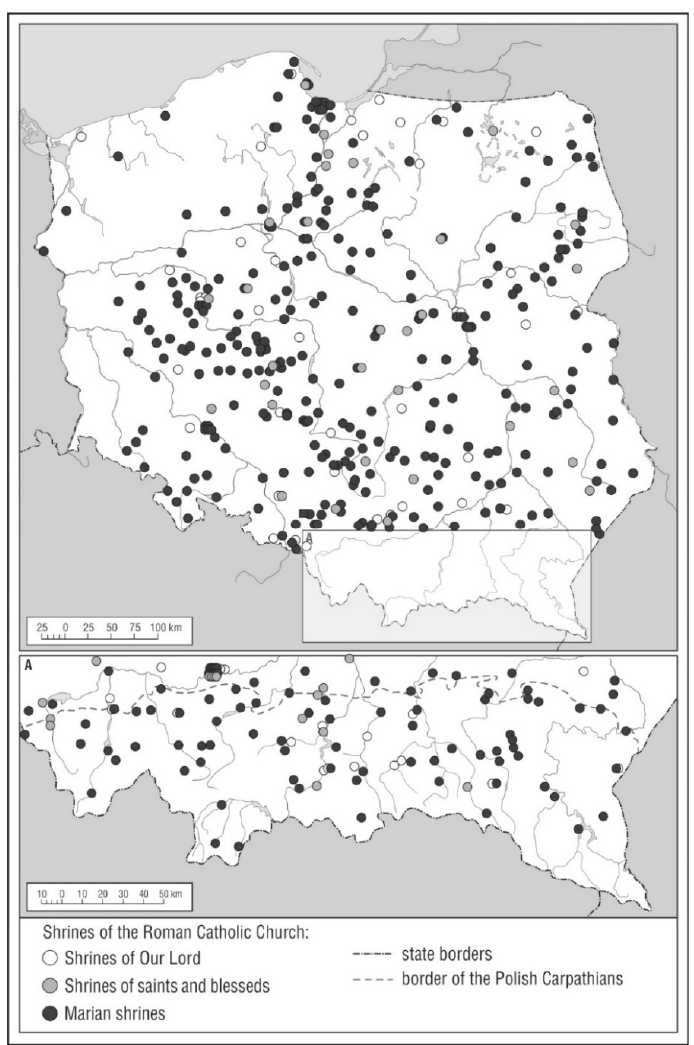
Figure 15. Shrines of the Catholic Church in Poland in 1989. Source: author. The pilgrimages of Pope John Paul II to Poland and the beatifications or canonizations of figures from Poland by the Pope had an immense influence on the development of Polish shrines, and on the distinct development of pilgrimages and religious tourism during the period of 1990 – 1998 (Mróz 2014). During his pontificate, John Paul II made eight pilgrimages to Poland. Six of them occurred during the Vatican II era under discussion here (in 1979, 1983, 1987, 1991, 1995, and 1997). In the course of these six pilgrimages to Poland, Pope John Paul II visited more than 30 shrines (Jackowski and So ł jan 2005). On his pastoral visits to Poland, Pope John Paul II crowned 21 images of the Mother of God (Jod ł ówka, Ł ukawiec, Kielce, Ł om ż a, E ł k, Kalisz-Nied ź wiady, Wadowice, Dar ł owo, Wroc ł aw, Krzeszów, Gniezno, Skulsk, Haczów, Ja ś liska, Wielkie Oczy, Jamna, Wejherowo, Warszawa, Jaworzno, and Wadowice i Bydgoszcz). It should be emphasized that during his pontificate, John Paul II canonized 9 Poles and beatified 155 (www.opoka.org.pl/biblioteka/T/TH/THO/25jp/turek_kanonizacje.html; accessed on 29 January 2021). As a result of these canonizations and beatifications, new shrines were established in Poland. On 18 April 1993, Pope John Paul II beatified Sister Faustina Kowalska, the Apostle of Divine Mercy, who was later canonized on 30 April 2000. The first shrine of Divine